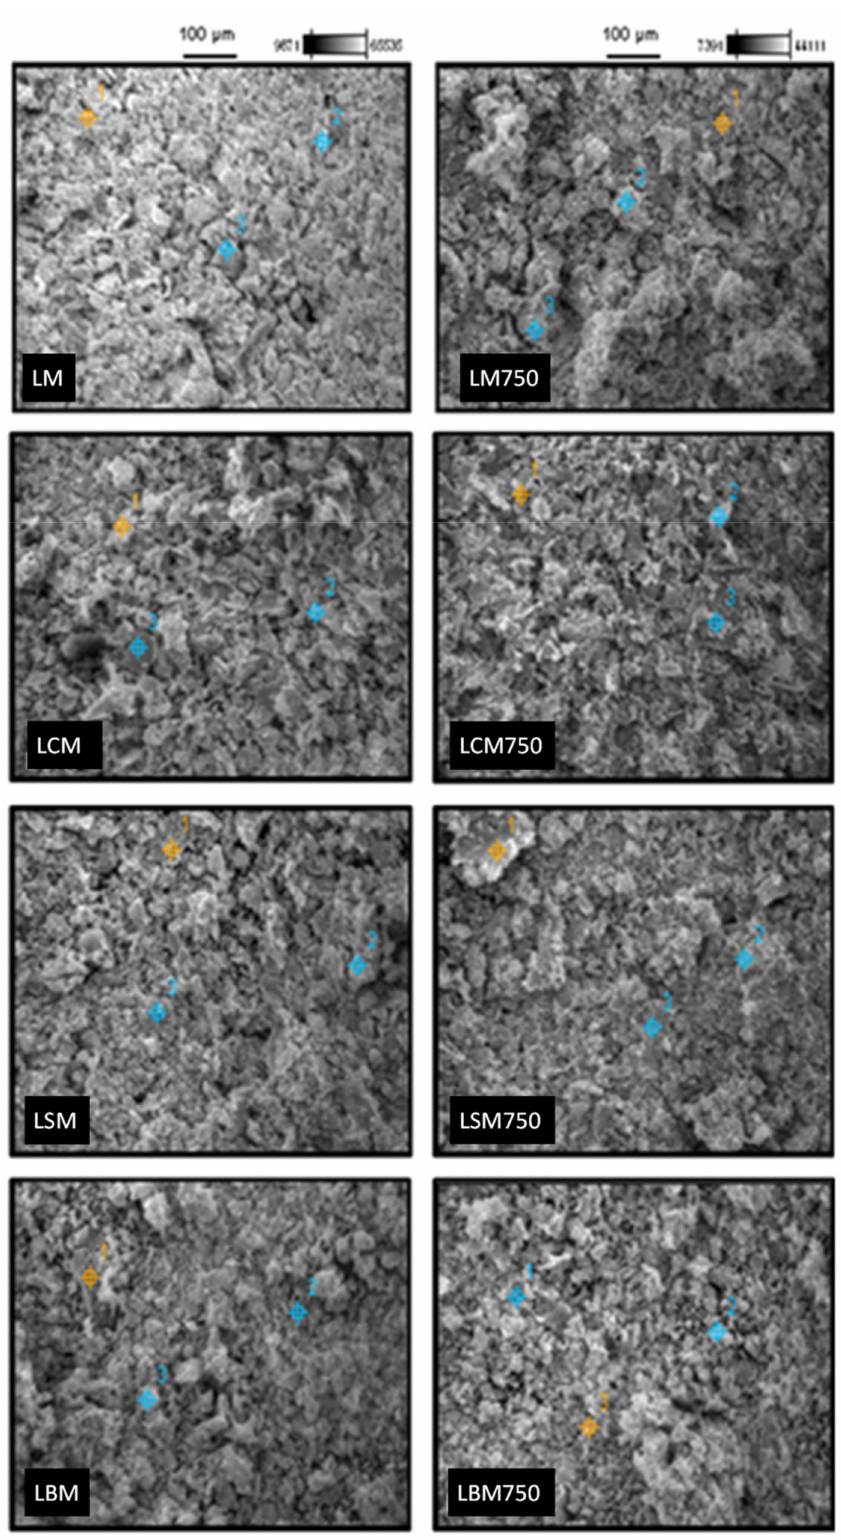
Figure 8. SEM images of the studied samples. EDS analysis points allowing the elemental % data gathered in Table 4 are